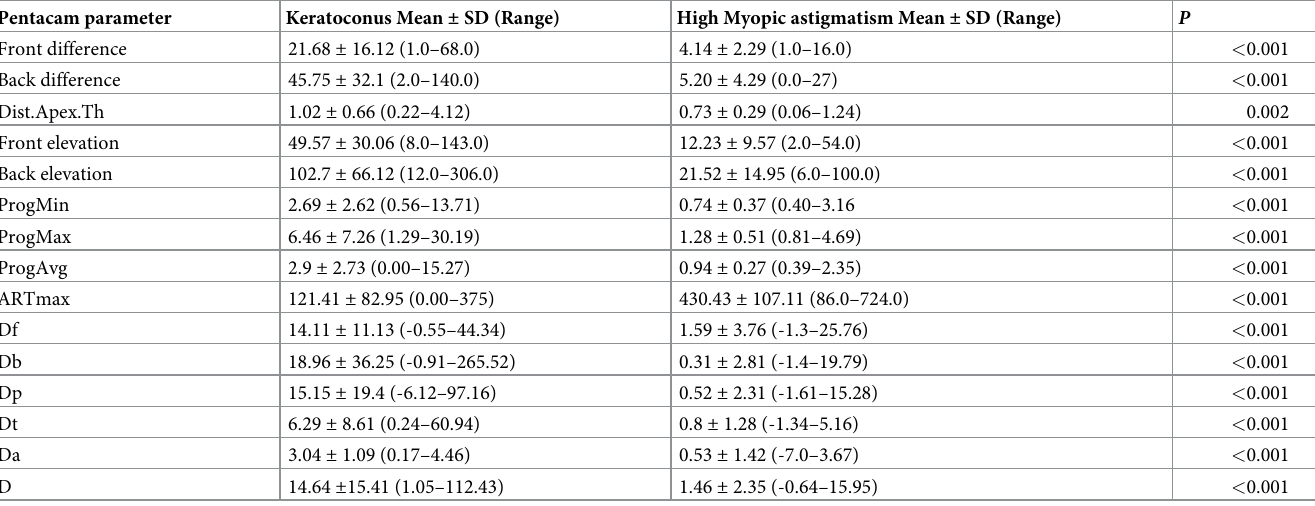
Dist.Apex.Th: distance from corneal apex to thinnest location, ProgMin/Max/Avg: progression index, ARTmax: maximum Ambrosio´ relational thickness, Df: deviation of front elevation difference map, Db: deviation of back elevation difference map, Dp: deviation of average pachymetric progression, Dt: deviation of minimum thickness, Da: deviation of ARTmax, D: total deviation value.